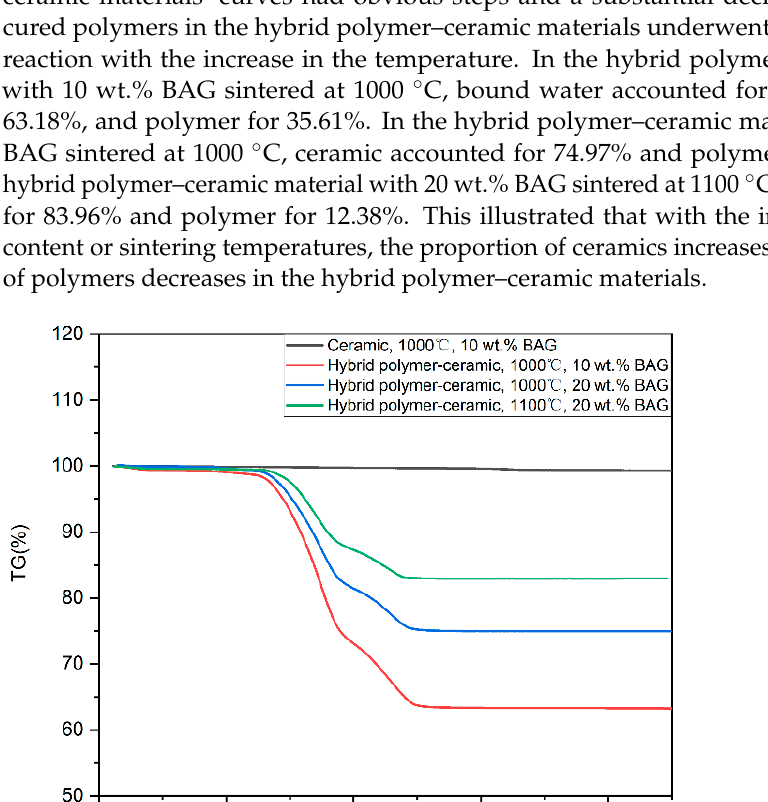
Figure 5. XRD patterns of ceramics with different sintering temperatures and different BAG